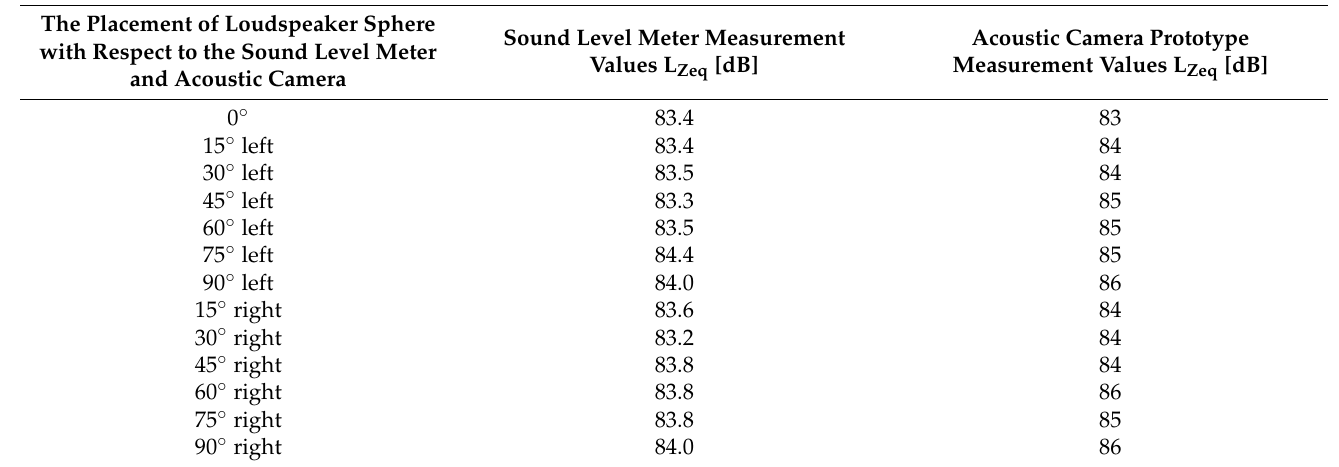
Figure 14. The rotation (by degrees) of omnidirectional sound source (i.e., sphere speaker) in front of the acoustic camera prototype. Table 9. The measured sound pressure values using the Brüel & Kjær 2250 sound meter (keeping in mind the rotation in 15 degrees steps) and acoustic camera prototype.